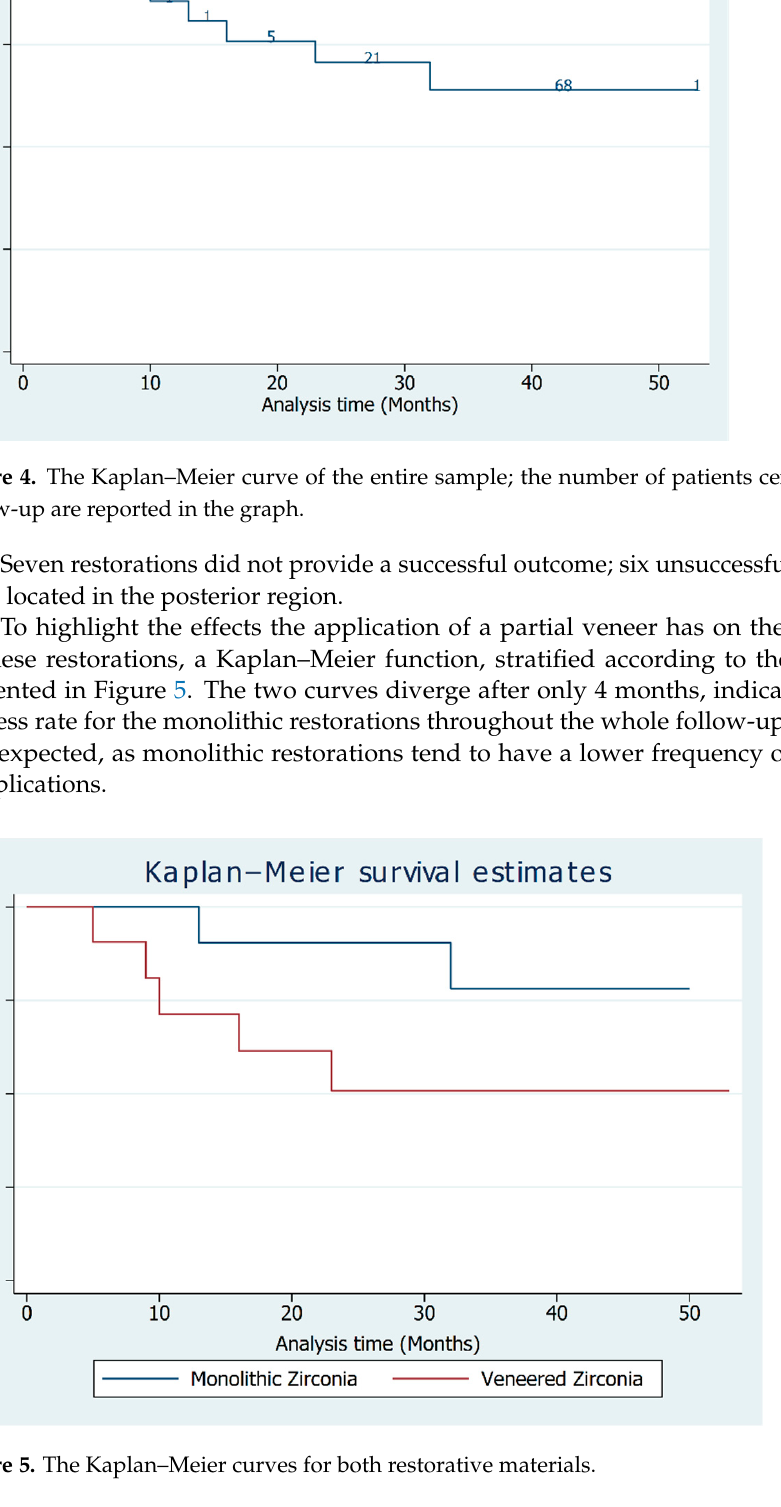
Table 3. Survivor functions at major time points according to the different materials adopted . Time